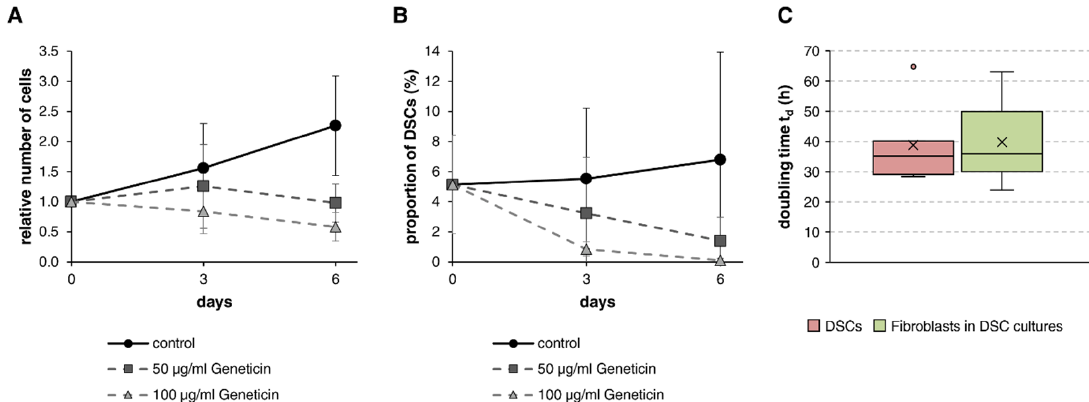
Figure 2. Geneticin treatment of DSC ‐ fibroblast co ‐ cultures. Dermal cells were cultured in StemPro hESC medium without Geneticin or with 50 μ g/mL or 100 μ g/mL Geneticin for two days, and cell growth was monitored for a total of six days. Number of total cells in relation to the cell count of control cells at day 0 ( A ) and frequency of DSCs in culture ( B ) were measured at days 0, 3, and 6. Values are presented as mean ± SDs. Sample size: n = 3. ( C ) Doubling time of DSCs and the respective fibroblasts in co-cultures without Geneticin treatment. Boxplot displaying the median with 25th/75th percentiles. The cross (×) inside the box indicates the mean DSC frequency. Dots represent outliers. Sample size: n = 7.